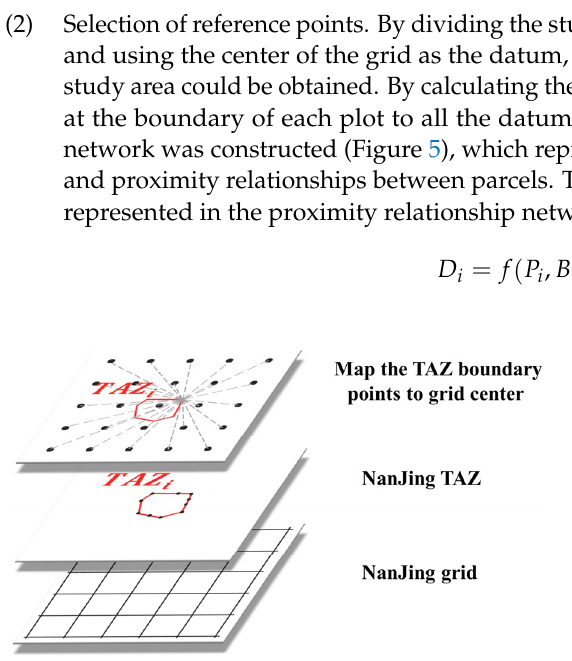
Figure 5. Proximity relation network of TAZs.